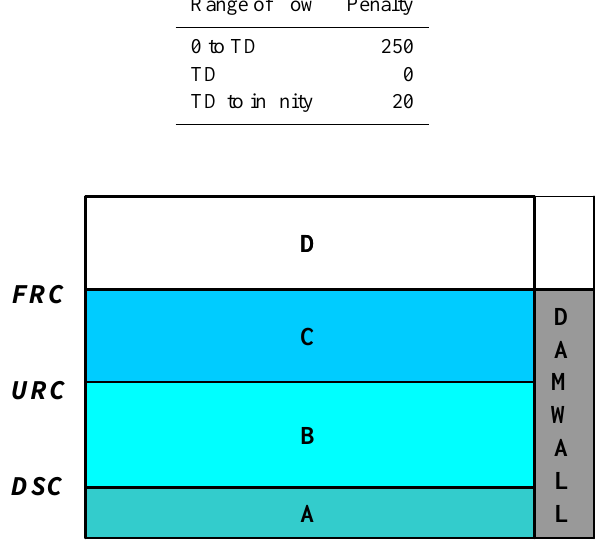
Table 3. Example of link penalty in the WRYM. Source: WRYM User Guide – 4.1.1. Figure 3